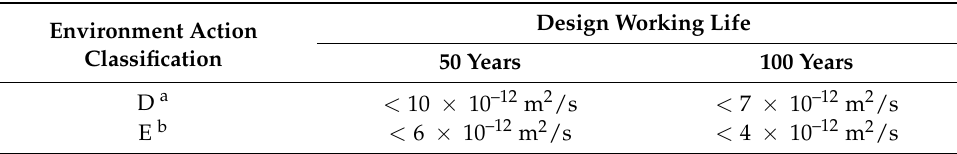
Table 7. The chloride diffusion coefficient limitation of concrete